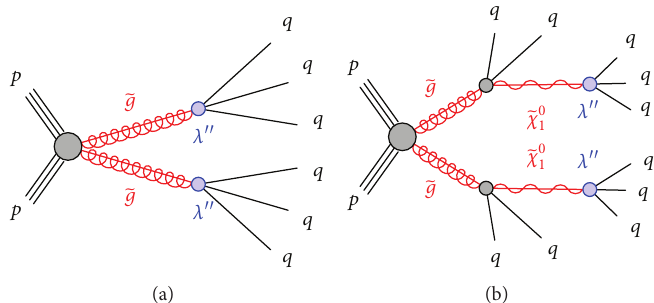
Figure 11: Diagrams for multijet processes considered for the analysis [44]. The gray shaded circles represent effective vertices that include off-shell propagators, and the blue shaded circles represent effective RPV vertices allowed by 𝑈𝐷𝐷 𝜆 󸀠󸀠 𝑖𝑗𝑘 couplings with off-shell propagators (from [44]).